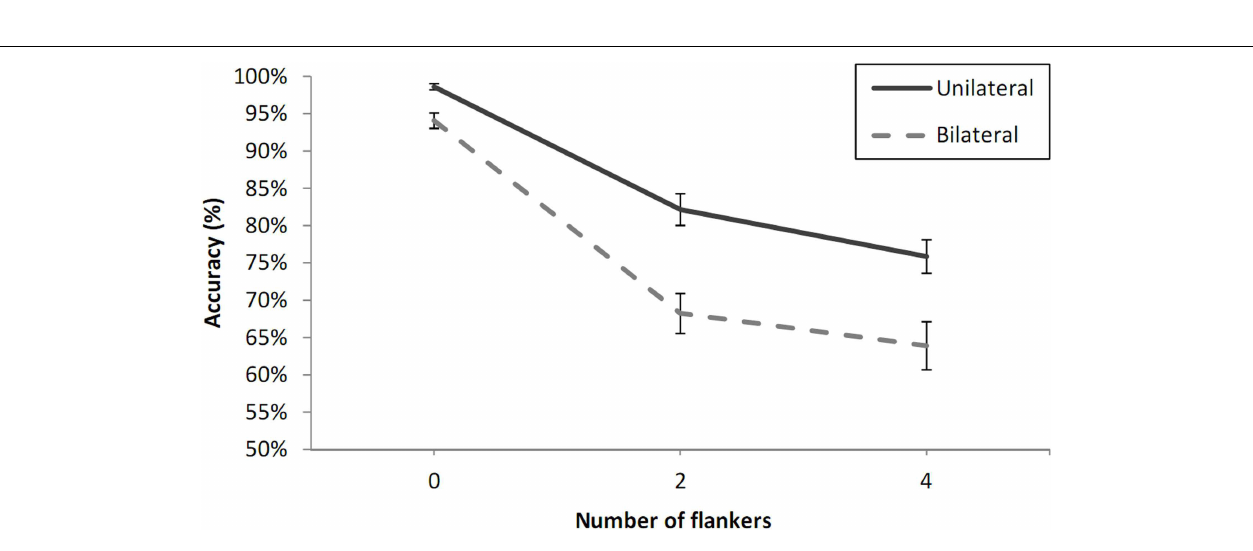
FIGURE 4 | Percent correct 2AFC to letter targets under unilateral and bilateral presentation conditions and as a function of the number of flankers (Xs) in Experiment 1B. Error bars are standard